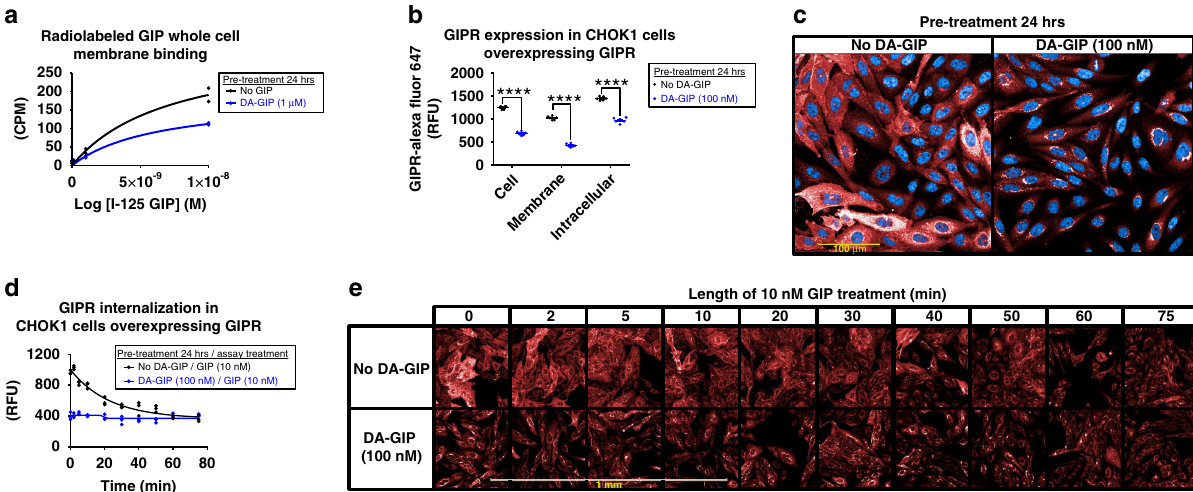
Fig. 8 Chronic GIPR agonism increases membrane GIPR internalization in vitro. a HEK293T cells overexpressing GIPR used to determine homologous whole cells 125 I-GIP membrane binding. Cells treated with or without DA-GIP, washed, and binding using 125 I-labeled human GIP was measure as CPM in a TopCount NXT gamma counter and plotted as % 125 I-GIP bound. n = 2 wells/treatment. b , c Comparison of whole cell, membrane, and intracellular GIPR (red, Alexa Fluor 647) content in CHOK1 cells overexpressing GIPR pre-treated with or without DA-GIP for 24 h. b Quantitated GIPR fl uorescence (RFU) and c representative image. n = 6 wells/treatment, two-way ANOVA with Sidak ’ s test for multiple comparisons, **** p ≤ 0.0001. Data are presented as mean values ± SEM. d , e Time course comparison of GIPR internalization upon stimulation with GIP in CHOK1 cells overexpressing GIPR (red, Alexa Fluor 647) pre-treated with or without DA-GIP for 24 h. d , Quantitated membrane GIPR fl uorescence (RFU) with background fl uorescence subtracted and e , representative images, n = 3 wells/treatment. Data are presented as mean values ± body weight, scWAT, eWAT, or liver weight between groups